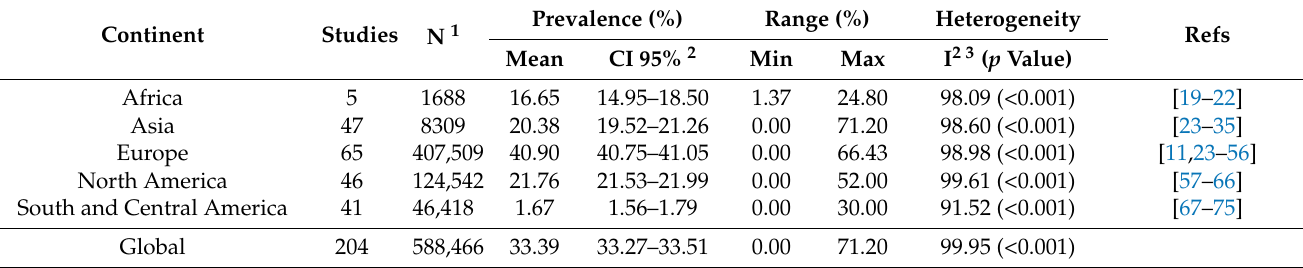
Prevalence (%) Range (%)